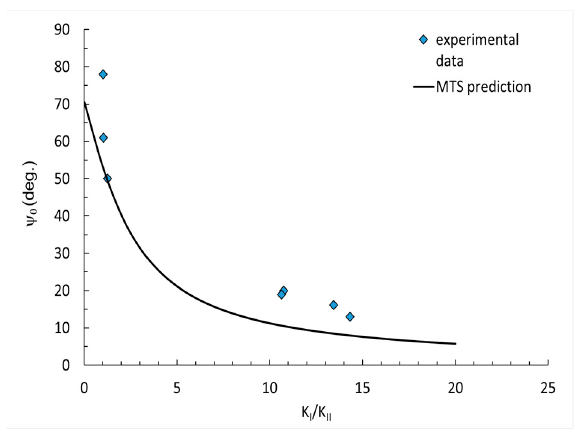
Figure 6. Crack initiation angles for pure resin.